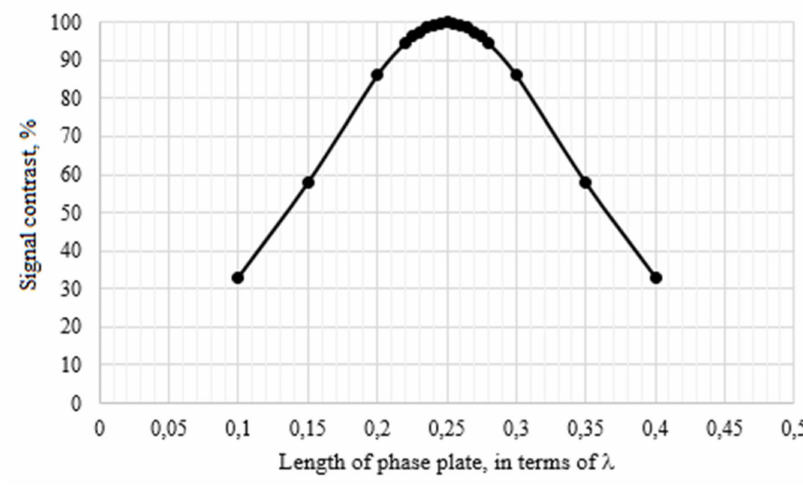
Figure 20. Contrast of the interference signal vs. length of the phase